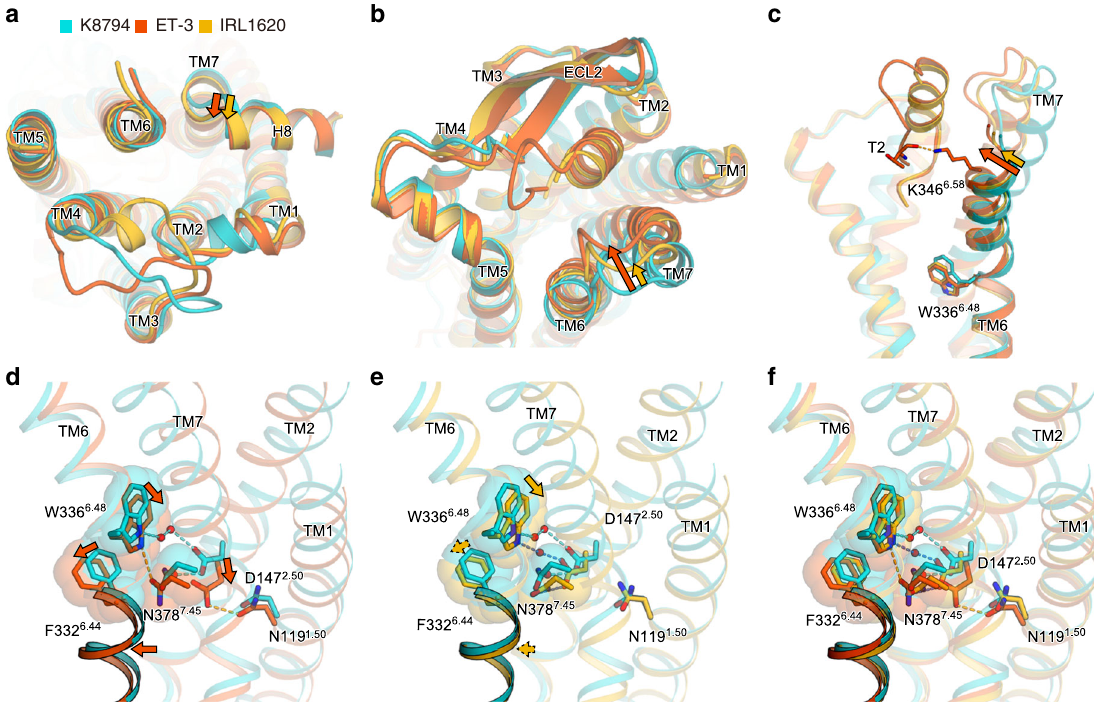
Fig. 5 Comparison of the K8794, ET-3, and IRL1620-bound structures. a – c Comparison of the K-8794-bound inactive (PDB 5X93), IRL1620-bound partially active, and ET-3-bound active ET B structures, coloured turquoise, orange, and orange-red, respectively. The ET B receptors and agonist peptides are shown as ribbon models, viewed from the intracellular side ( a ), the extracellular side ( b ), and the membrane plane ( c ). The cytoplasmic cavity for the G-protein binding is still hindered by the inwardly-oriented TM6 in the ET-3 and IRL1620-bound receptors, representing the inactive conformations. This is consistent with the notion that the fully active conformation is only stabilized when the G-protein is bound, as shown in the previous nuclear magnetic resonance (NMR) and double electron – electron resonance (DEER) spectroscopy study 38 . d – f Superimposition of the ET B structures bound to K-8794 and ET-3 ( d ), K- 8794 and IRL1620 ( e ), and K-8794, IRL1620, and ET-3 ( f ), focused on the intermembrane parts. The receptors are shown as ribbons, and the side chains of N119 1.50 , D147 2.50 , F332 6.44 , W336 6.48 , and N378 7.45 are shown as sticks with transparent surface representations. Waters are shown as red spheres. The dashed lines show hydrogen bonds coloured in the respective structures. The arrows show the structural changes on ligand